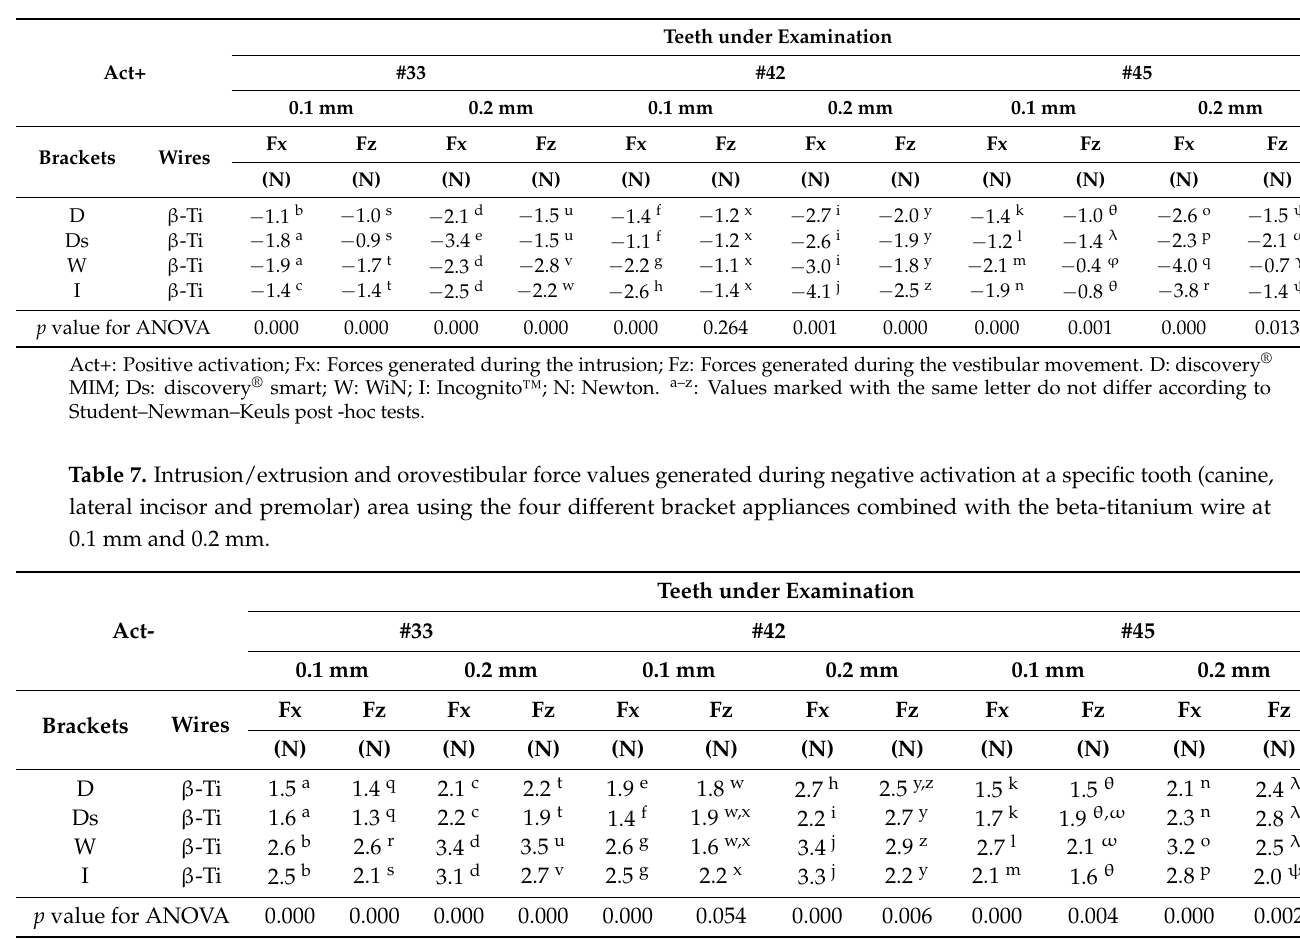
Table 6. Intrusion/extrusion and orovestibular force values generated during positive activation at a specific tooth (canine, lateral incisor and premolar) area using the four different bracket appliances combined with the beta-titanium wire at 0.1 mm and 0.2 mm.